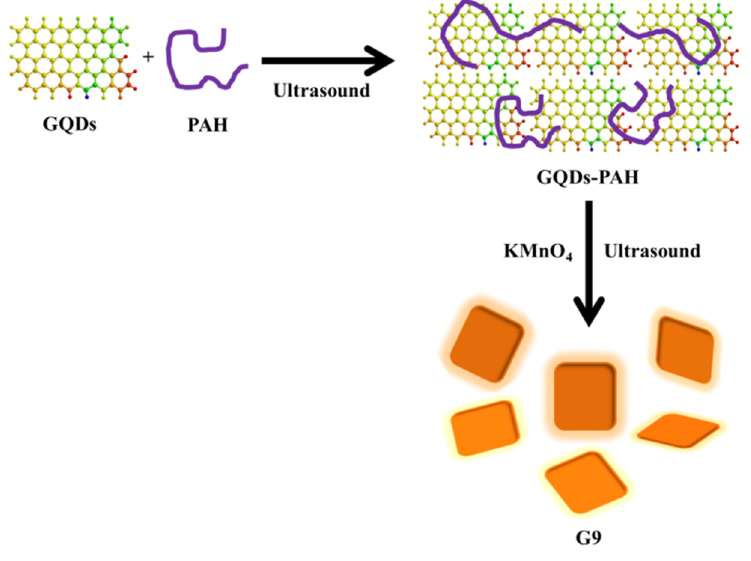
Figure 11. Schematic diagrams of the preparation of the GQDs-MnO 2 nanocomposite ( G9 ) and GSH responsiveness with the fluorescence off–on process. Reprinted from [66] with permission from Elsevier.